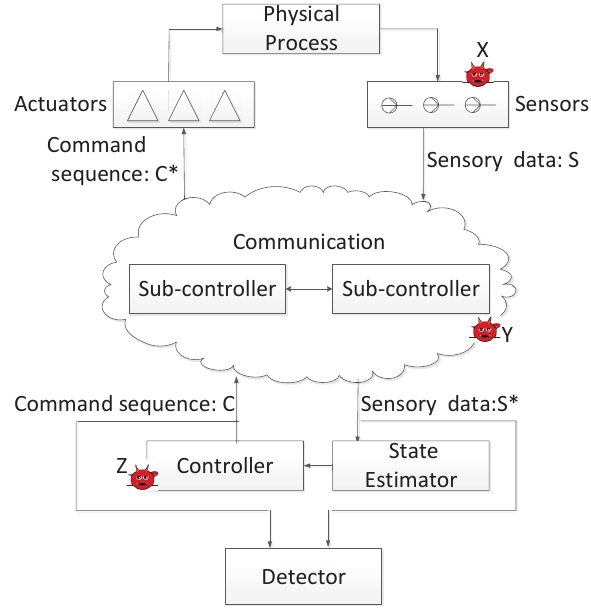
Figure 1. A simple model of CPS, where X , Y and Z denote attack entry points [15]. Adapted with permission from [15], Copyright Elsevier, 2016.